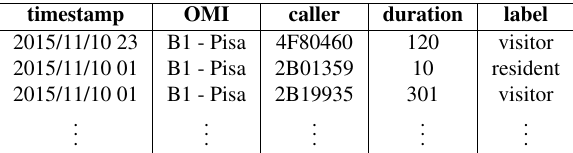
Table 2. Final dataset, containing the starting data together with